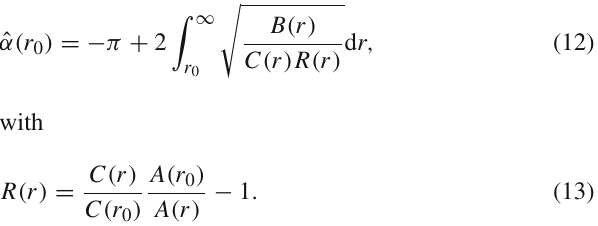
Fig. 2 It shows the positions of the antiphoton and photon spheres x a and x m in the top panel, the coefficients of the strong deflection limit ¯ a + and ¯ a − in the middle panel and ¯ b + and ¯ b − in the bottom